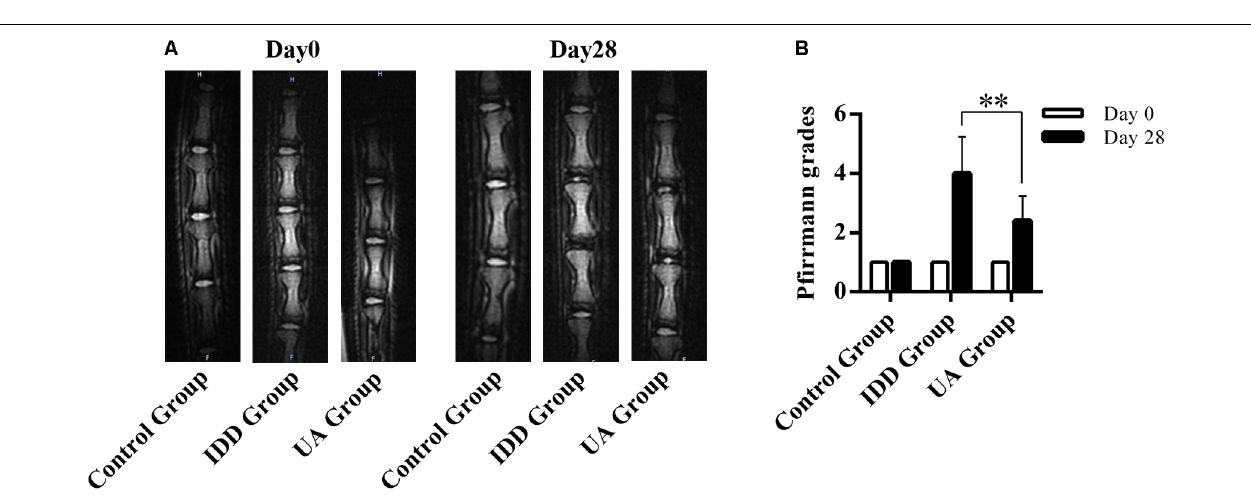
FIGURE 5 | UA treatment improves the MRI grading of IDD. (A,B) T2-weighted image of rat tails. Grading of disc degeneration was evaluated according to a grading system reported by Pfirrmann et al. The data represent the means ± SD. ∗∗ P < 0.01 compared with the IDD